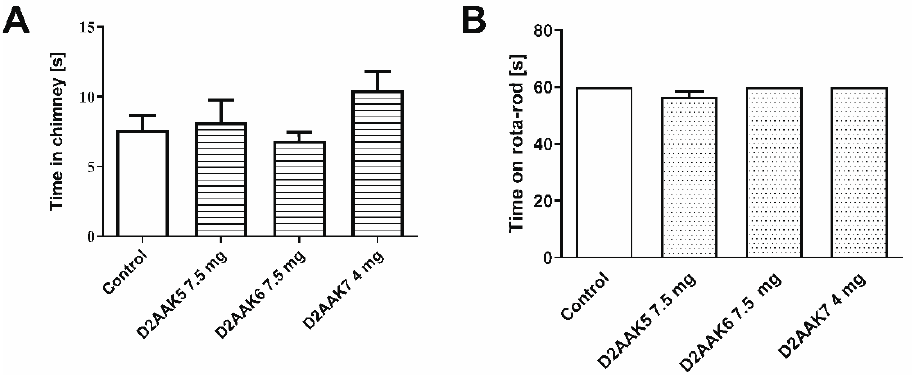
Figure 9. The influence of the tested compounds D2AAK5, D2AAK6 (7.5 mg/kg), and D2AAK7 (4 mg/kg) on motor coordination in mice evaluated in chimney ( A ) and rota–rod ( B ) tests. Investigated compounds were injected i.p. 60 min before the test. Data are expressed as mean ± SEM values of the one independent experiment.